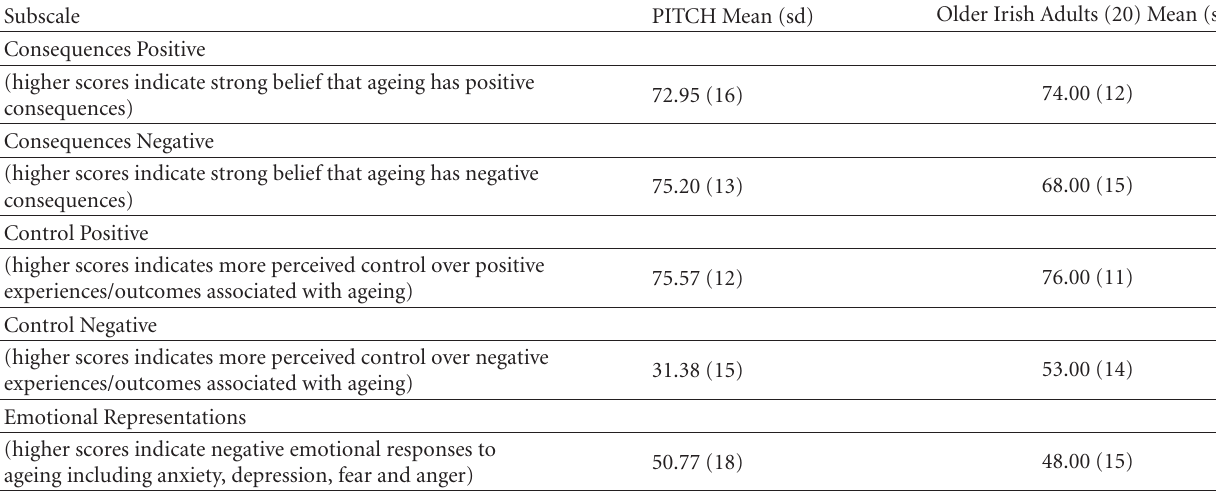
Table 2: Summary of APQ Subscale